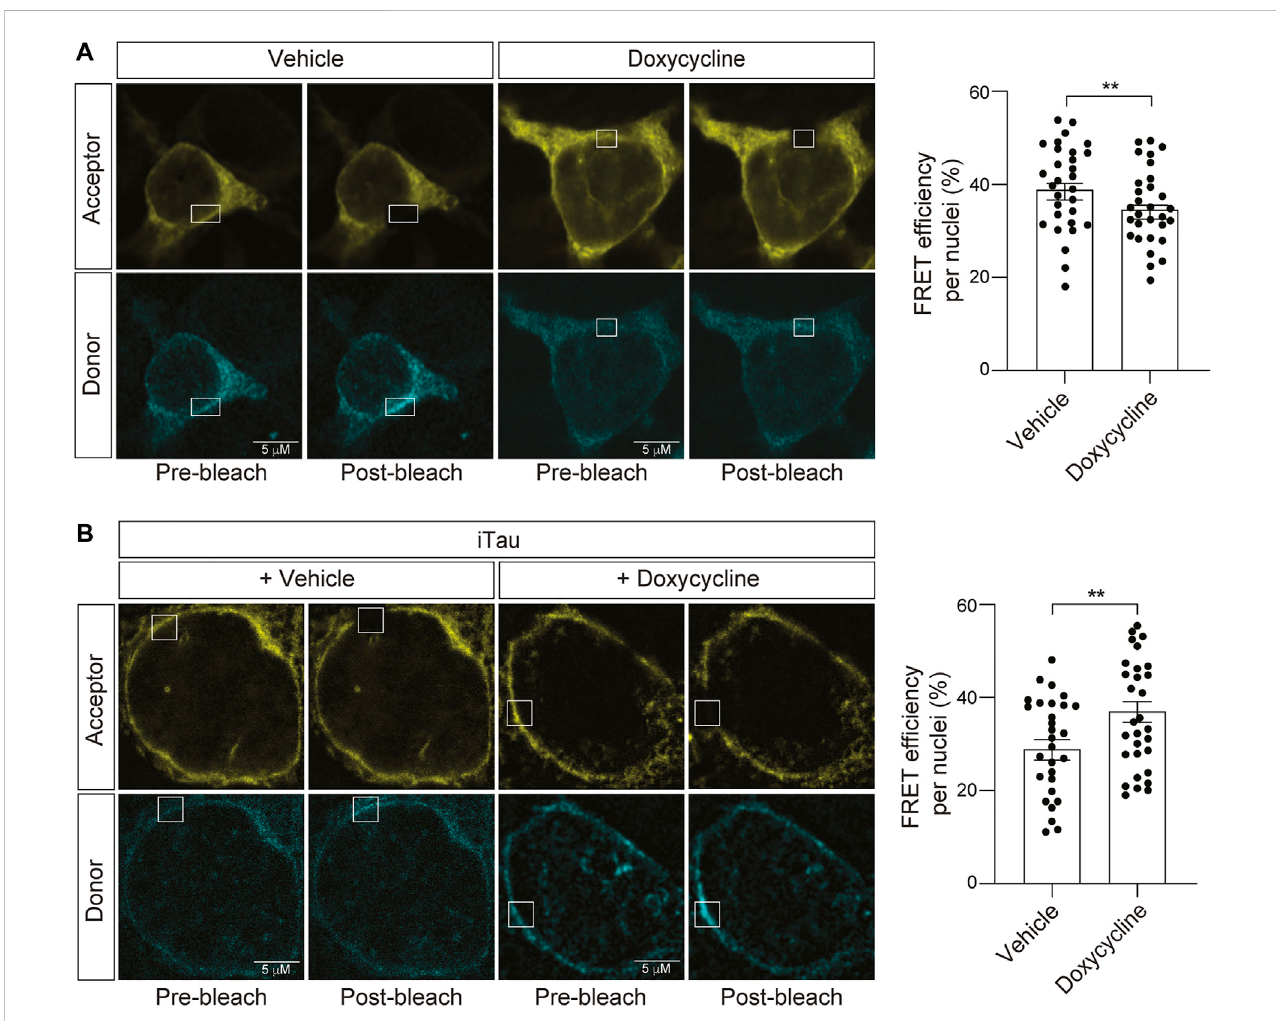
FIGURE 6 Induction of tau expression in iTau cells causes a decrease in nuclear tension. (A) Acceptor photobleach-based quanti fi cation of FRET in BE(2)-C cells after 24-h of doxycycline treatment reveals a doxycycline-induced increase in nuclear tension compared to vehicle (DMSO) treated cells. (B) Acceptor photobleach-based quanti fi cation of FRET in iTau cells after 24 h of doxycycline-mediated induction of tau expression compared to vehicle reveals a tau- induced decrease in nuclear tension. Each datapoint represents FRET analyzed in a single nucleus. Thirty nuclei were analyzed across three different wells (10 nuclei/well), t -test, ** p < 0.01. Error bars indicate